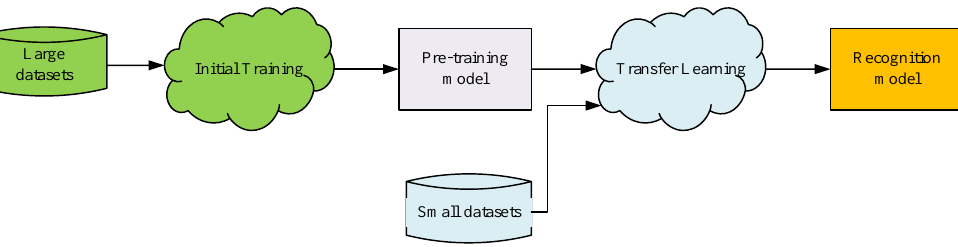
Figure 4. The training process of transfer learning.